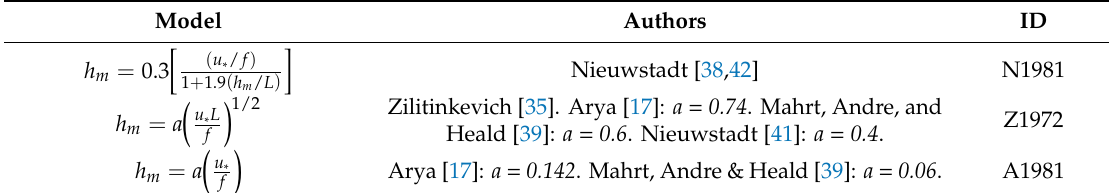
Table 3. Stable mixing height diagnostic algorithms. The equations give stable mixing height ( h m ) as a function of friction velocity ( u ∗ ) Monin–Obukhov length ( L ), and the Coriolis parameter ( f ). Model Authors ID (cid:20) h m = 0.3